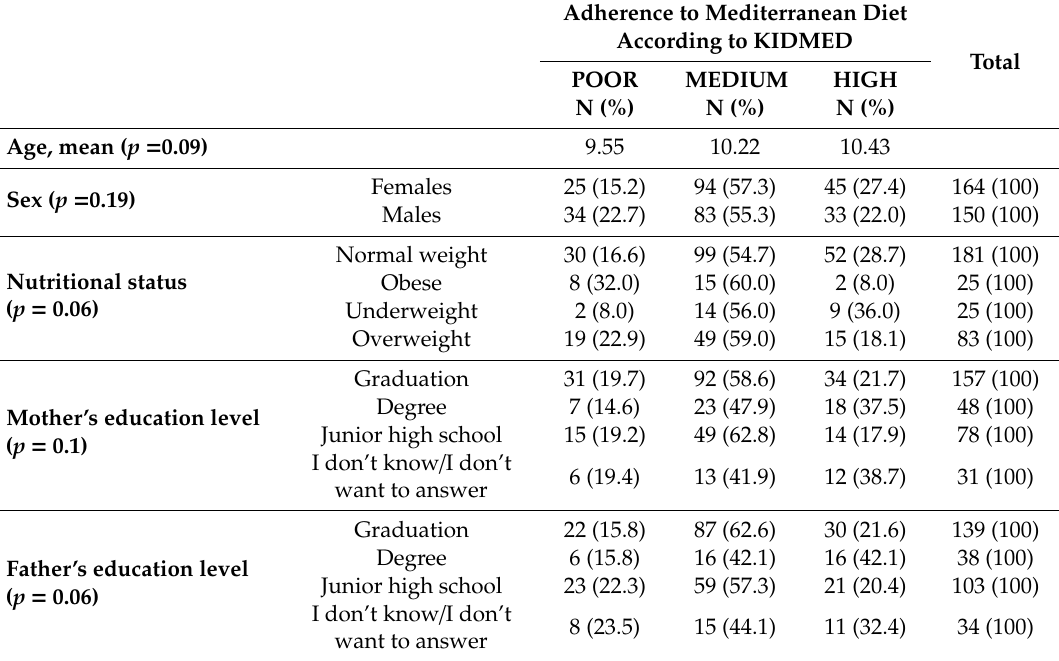
Table 3. Adherence to Mediterranean diet according to KIDMED questionnaire on sex, nutritional status, mother and father’s education